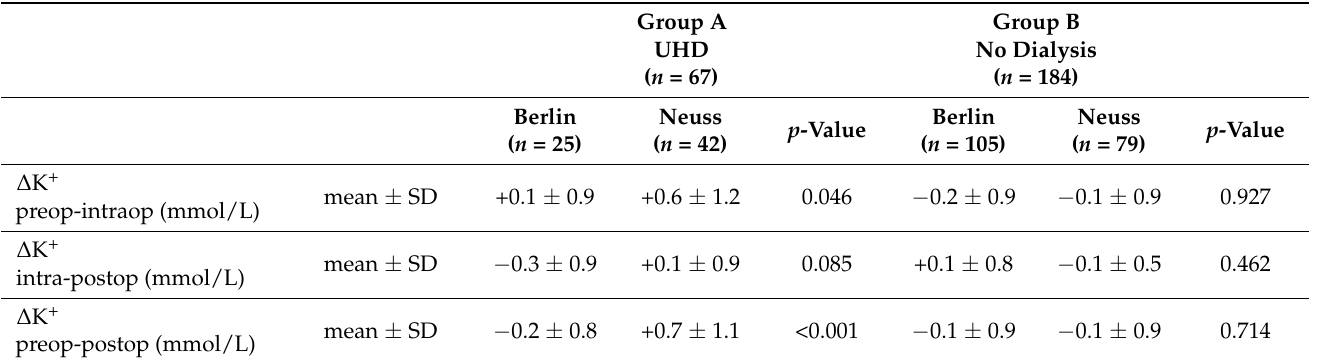
Table 4. Development of median serum potassium levels (SPL) comparing need for urgent hemodial- ysis (UHD) and the study centers. Group